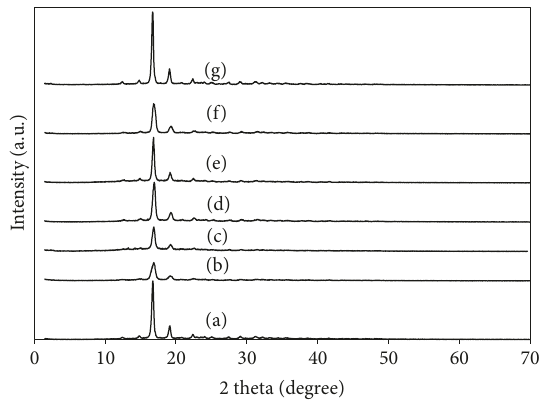
Figure 5: X-ray diffraction patterns of PLLA (a) and PLLA nanocomposites (b–g), (b) Zn/Al palmitate (1wt%), (c) Zn/Al palmitate (2wt%), (d) LHS (salicylate) (1wt%), (e) LHS (salicylate) (2wt%), (f) LHS (palmitate) (1wt%), and (g) LHS (palmitate) (2wt%).